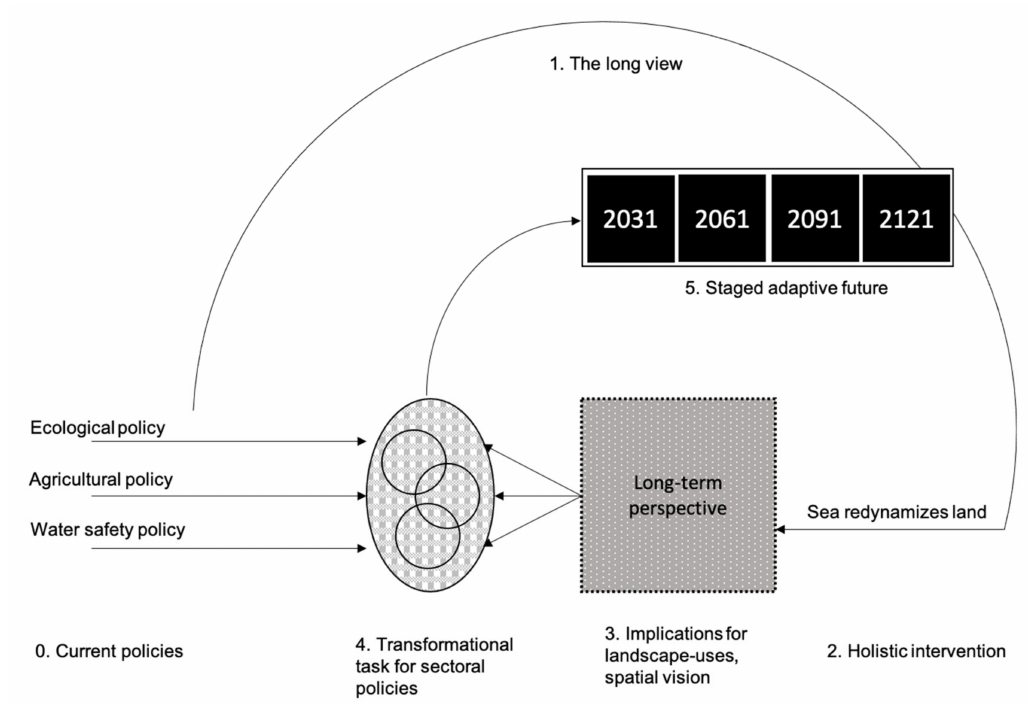
Figure 4. The methodology used in the